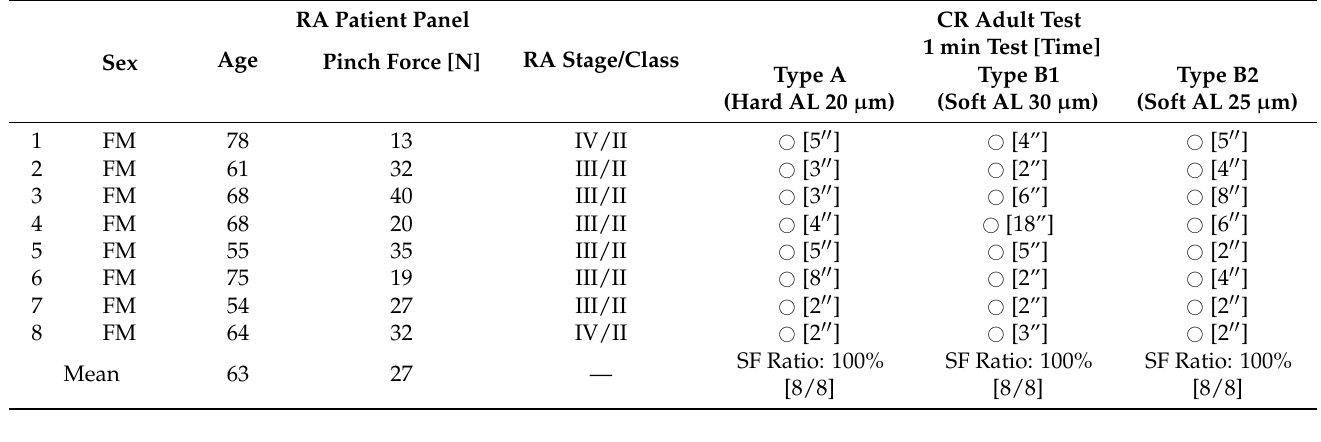
Table 5. CR Adult Test-2 on patients with RA.